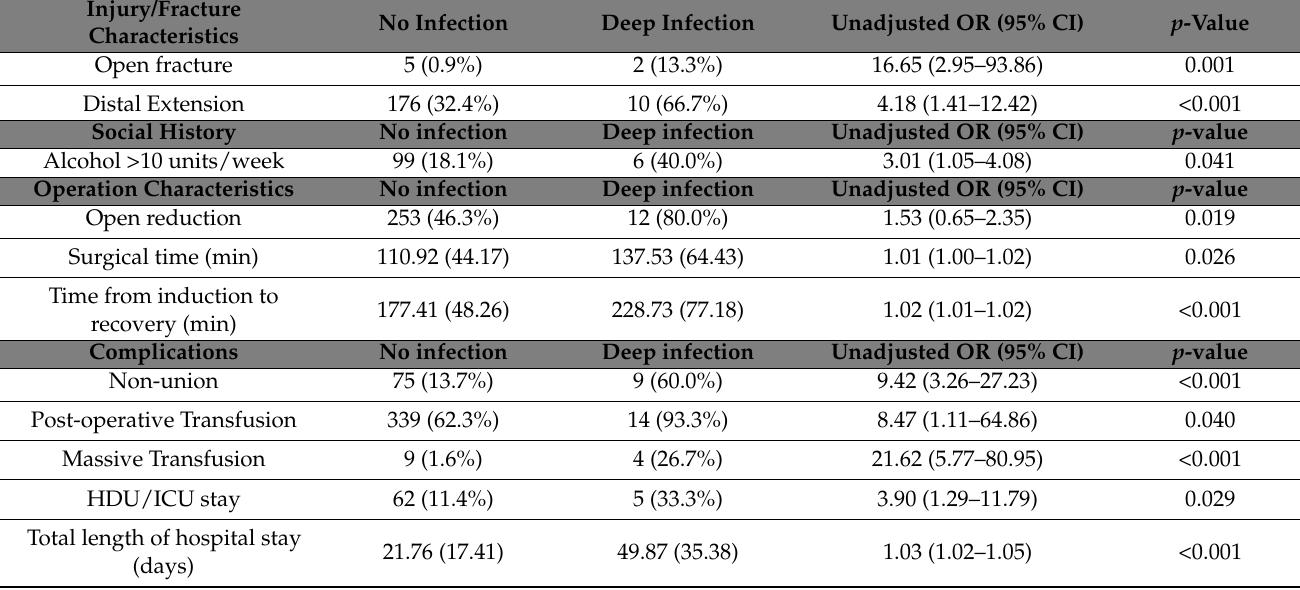
Table 4. Table presenting risk factors associated with deep infection.